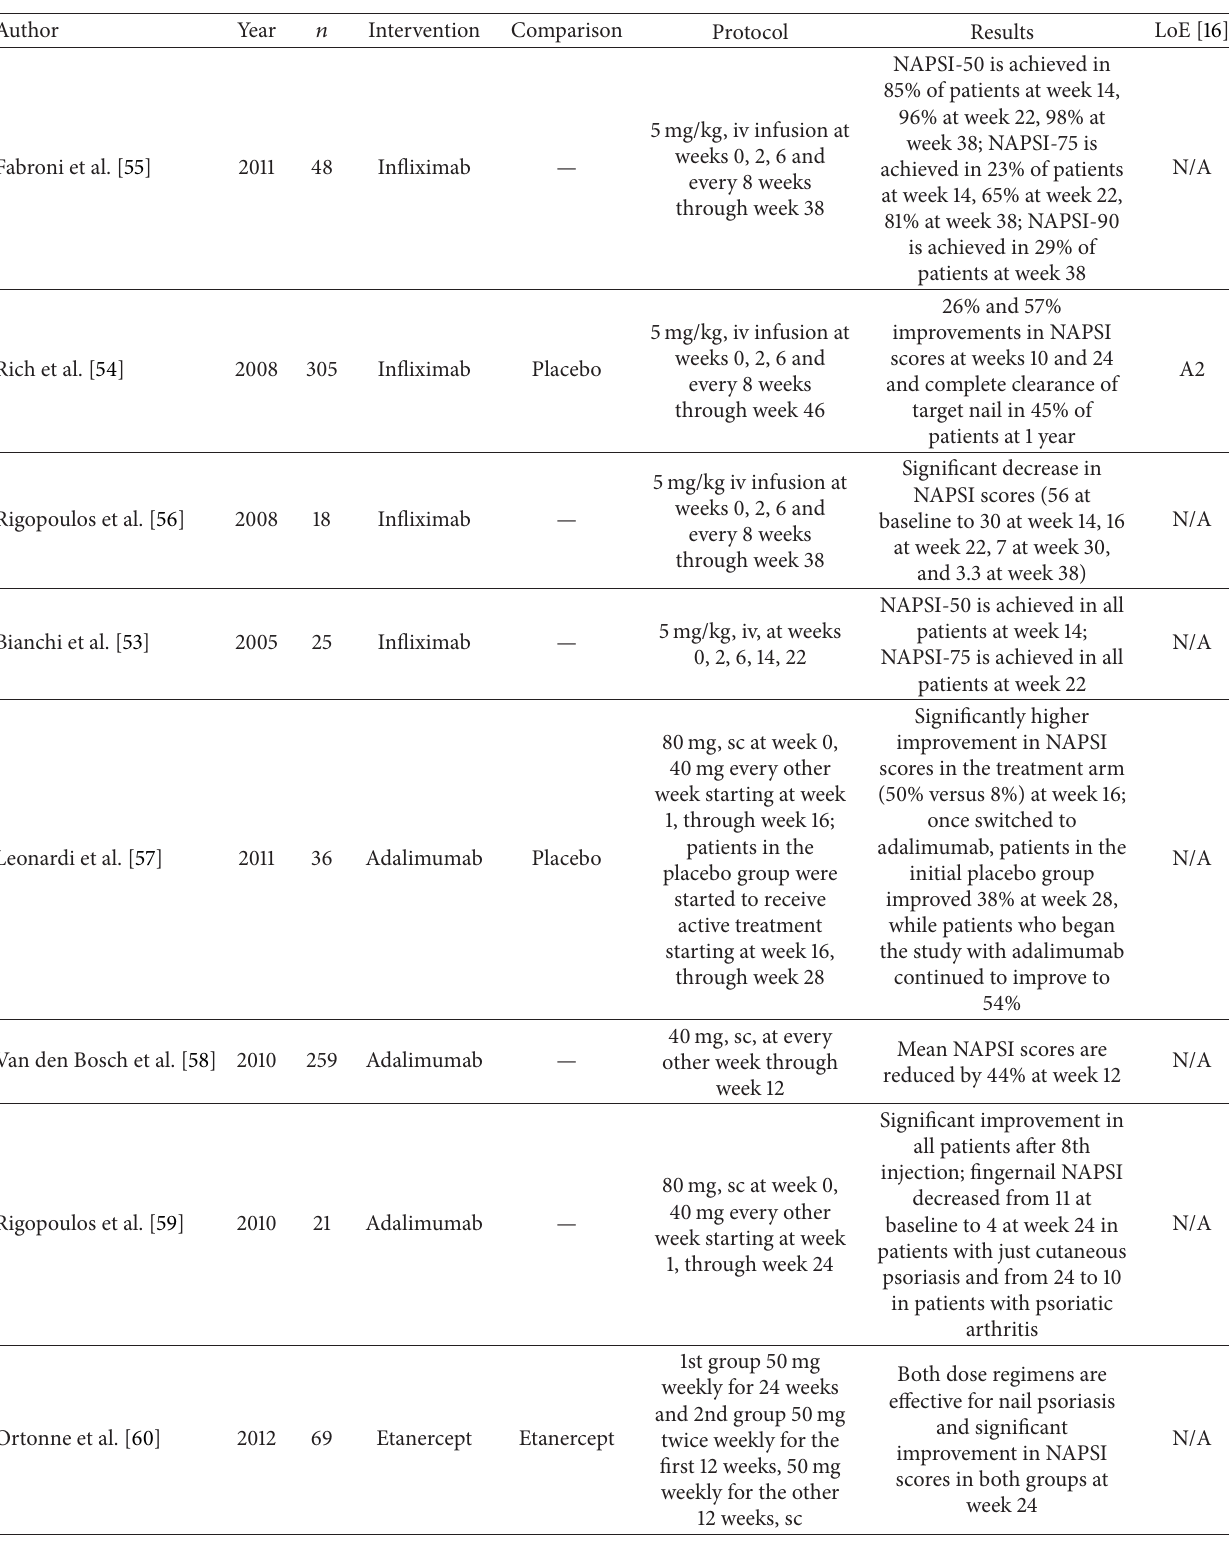
Table 3: Biologic therapies for treatment of nail